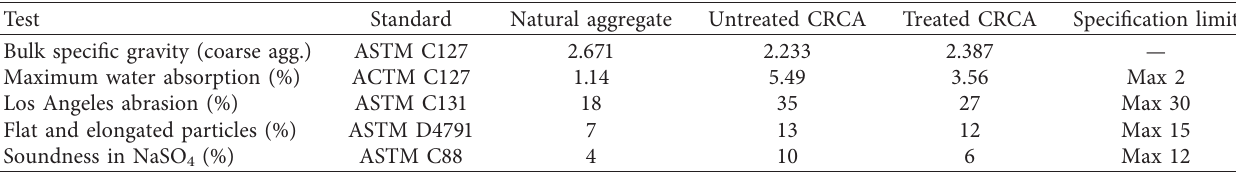
Table 3: Physical and mechanical properties of natural and recycled aggregates.